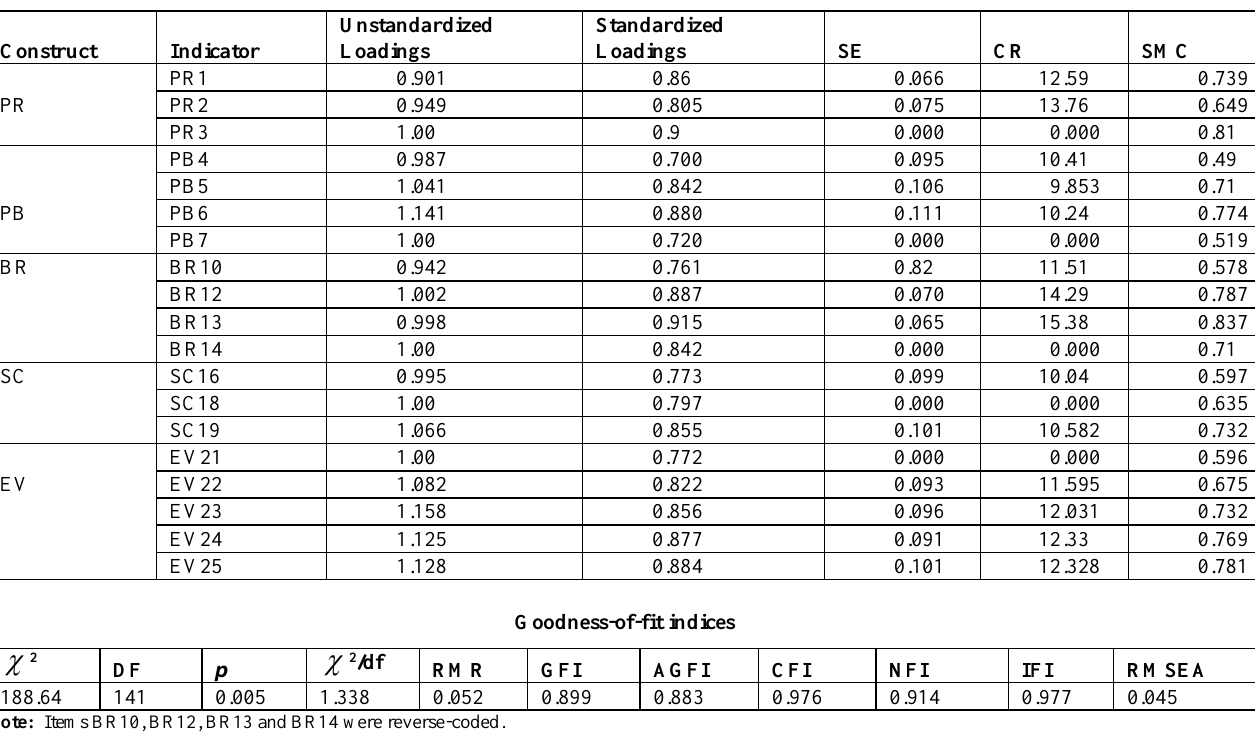
Table 5: Results of the CFA for the overall measurement model Construct